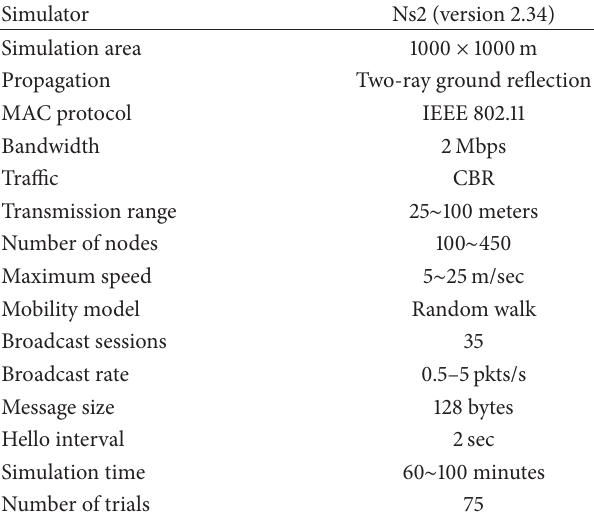
Table 2: Simulation parameters.